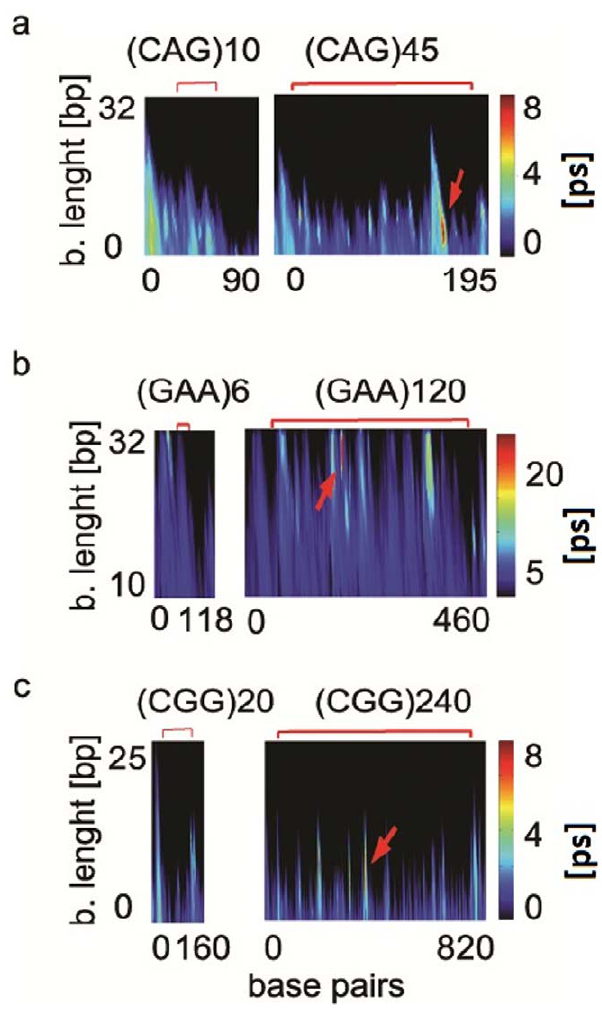
Figure 3. The TRS expansion has an effect on the DNA bubble spectrum. EPBD based LMD simulations have been conducted on the: a) (CAG.CTG) 45 repeats and healthy (CAG.CTG) 10 repeats with 30 bp flanking huntington gene sequence; b) (GAA.TTC) 120 and (GAA.TTC) 6 MRS that are embedded in 50 bp frataxin gene sequence; c) (CGG.GCC) 240 and (CGG.GCC) 20 repeats together with 50 bp FMR1 gene flanking sequence. The y-axis representsthe lengthofthe bubblesinbp; the x-axisrepresents the number of the base pairs; the color axis gives the bubble duration in psec. The brackets above the panels denote the repeated sequence; red arrows- the largest and long-lived base-pairs openings.